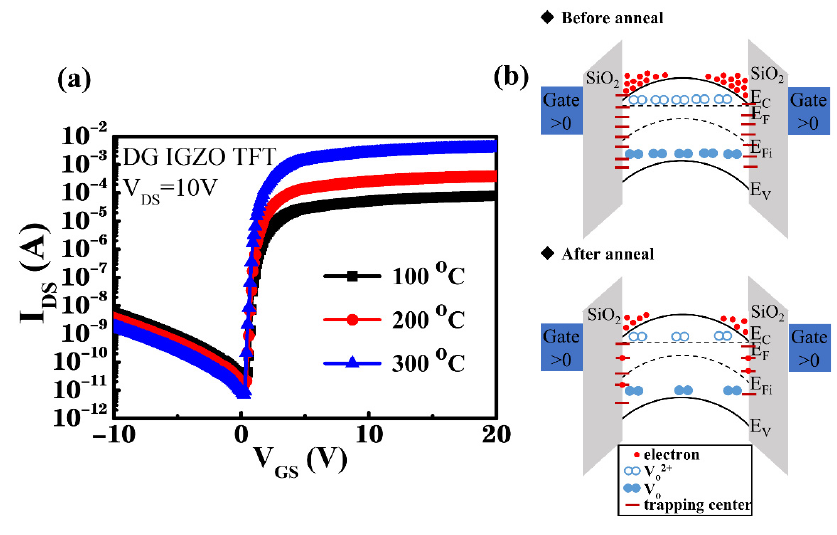
Figure 6. ( a ) I DS –V GS transfer characteristics of a DG TFT with a 33% O 2 plasma–treated IGZO channel layer and annealed at temperatures of 100, 200, and 300 °C. ( b ) Energy band diagrams for the DG TFTs before and after the thermal annealing process.